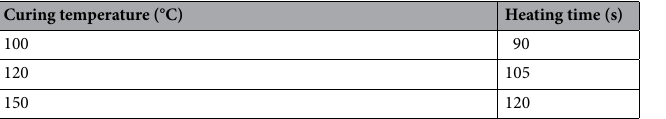
Table 2. Curing temperatures and times necessary to reach them in crosslinking rheological tests.